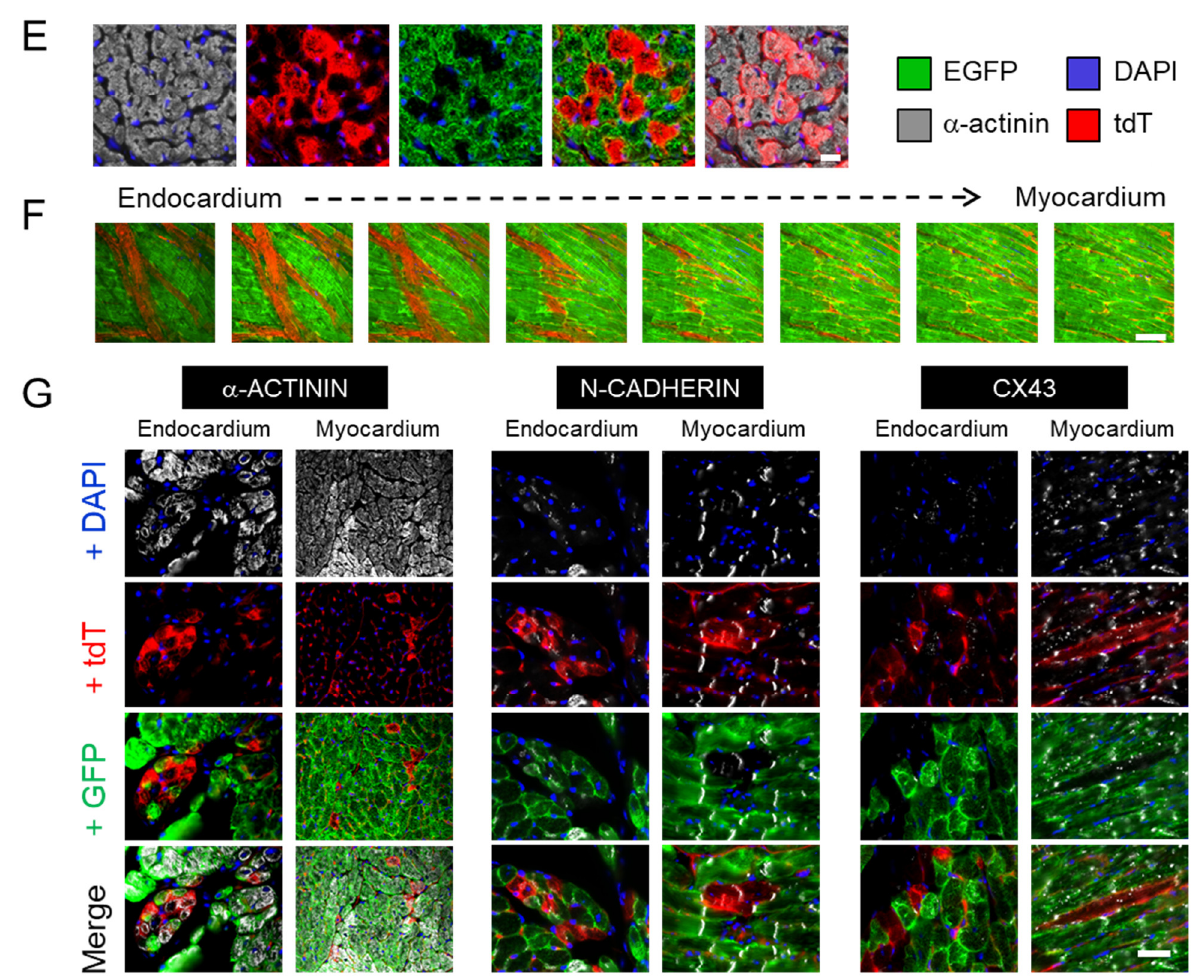
Figure 5. New myocytes originate from non-myocyte cells. ( A ) Experimental protocol. TGJ1 and WT control mice bearing Myh6- MerCreMer and ROSA26-mTmG transgenes were injected with Tamoxifen during 5 consecutive days to induce a conversion from tdT to EGFP expression specifically in CMs. The mice were subjected to Sham or TAC operation. After two weeks, the mice were injected twice with α NRR1 or α NRR2 antibody at four days interval. Mice were sacrificed and analyzed after 4 weeks of TAC. ( B ) Quantification of new tdT+ CMs in WT and TGJ1 mice subjected to Sham or TAC operation and treated with α NRR1, α NRR2 antibodies or none. The data show percentage of tdT+ CMs per heart section. The proportions of tdT+ CMs in the endocardium region are shown in Gray. *, p < 0.05 in TAC vs. Sham; †, p < 0.05 in α NRR vs. None; ‡, p < 0.05 in TGJ1 vs. WT ( n = 4–8 mice per group). ( C ) Representative whole heart tissue section showing the three main locations of tdT+ CMs (Red). The rectangles denote: ( a ) a perivascular region, ( b ), a ventricular myocardium region and ( c ) a endocardial region. The tdT+ CMs (arrowheads) in the three different localizations are shown at higher magnification in ( D ). ( E ) Cluster of tdT+ (Red) α -actinin+ (Gray) CMs and adjacent pre-existing EGFP+ (Green) CMs ( F ). Wholemount confocal serial sections in the endocardium to myocardium axis showing tdT+ CMs (Red) as a one-cell deep layer. ( G ) Characterization of the tdT+ CMs. Heart tissue sections were stained (Gray) with antibodies against α -actinin, to mark CM cytoplasm, N-Cadherin to mark intercalated disks, and against Connexin-43 to label gap junctions. Representative areas with new tdT+ CMs (Red) are shown, in the myocardium and in the subendocardium, adjacent to pre-existing CMs (Green). Scale bars in ( C ) = 0.5 mm, in ( D ) = 200 µ m (right) and in ( E – G ) = 50 µ m. Spatially, tdT+ and α -actinin+ CMs were found as clusters throughout the myocardium. In particular, important clusters were present in the ventricular walls adjacent to